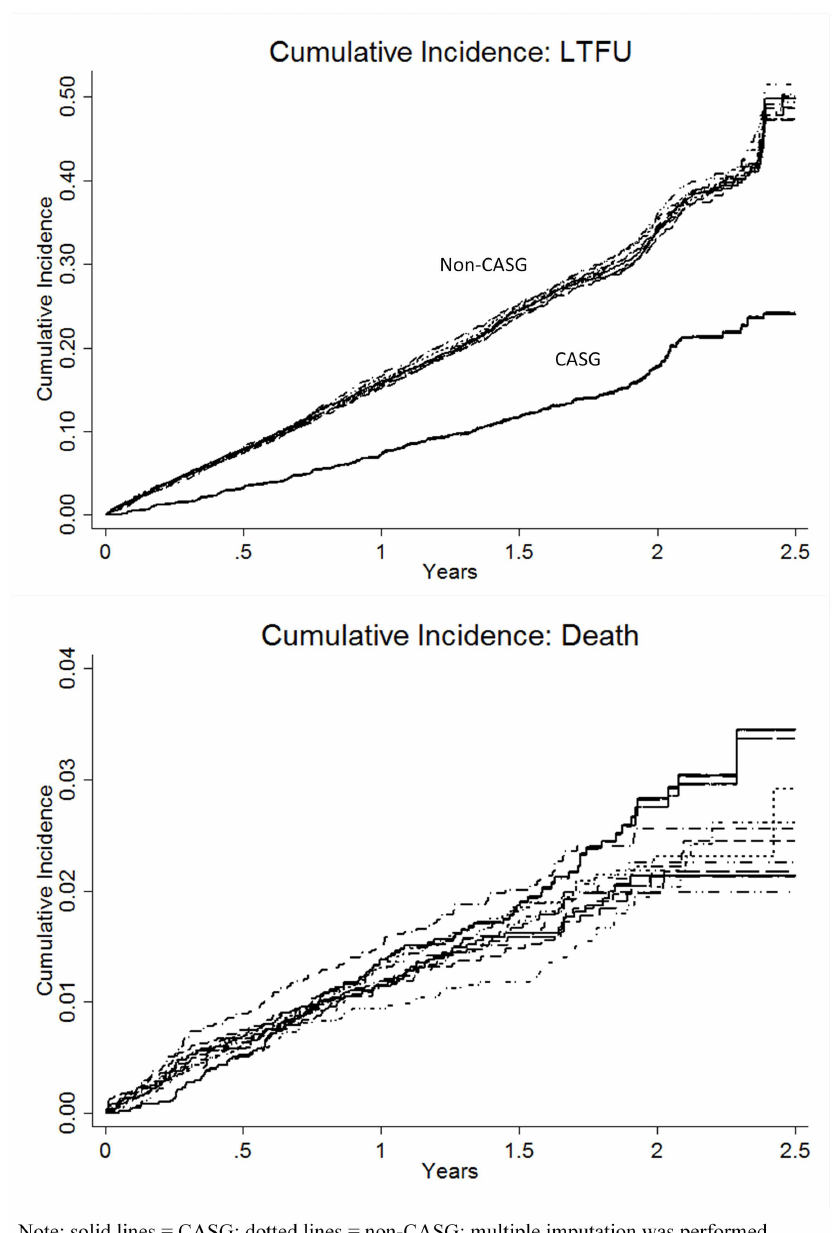
Fig 2. Cumulative incidence of LTFU and Death among matched CASG and non-CASG participants.